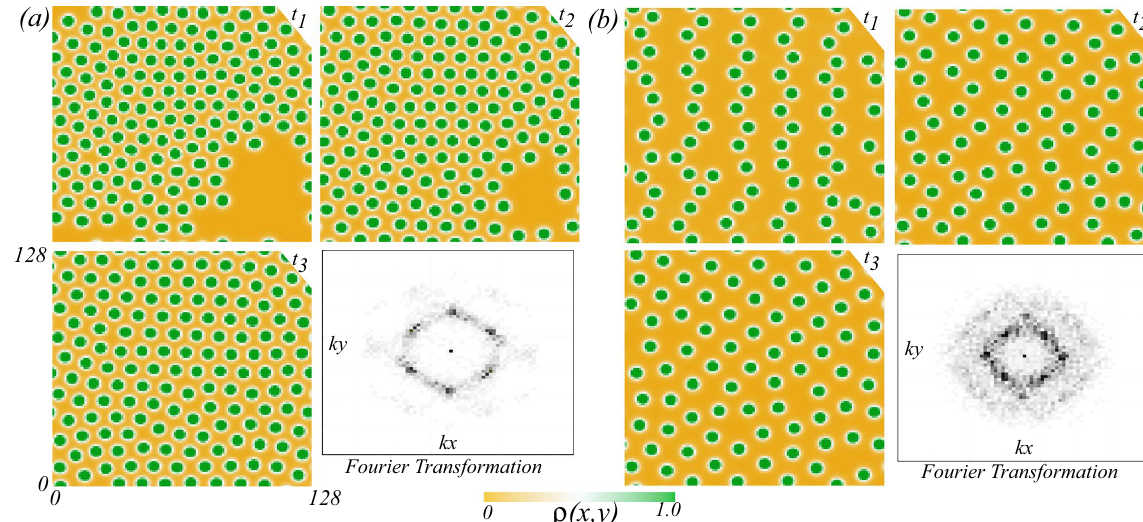
Figure 4. Temporal evolution of localised patches lattice of the interaction-redistribution model Eq. (3) with periodical boundary conditions, different initial distributions of localised spots ( t 1 < t 2 < t 3 ), and respective Fourier transform of the last state. Parameters are η = 0.5, κ = 1.0, D = 0.6, Γ = 3, and α = 1. The density of localised vegetation patches high ( a ) and low ( b ). For the high and the low density of localised spots, the tendency is to a hexagonal or square lattice,